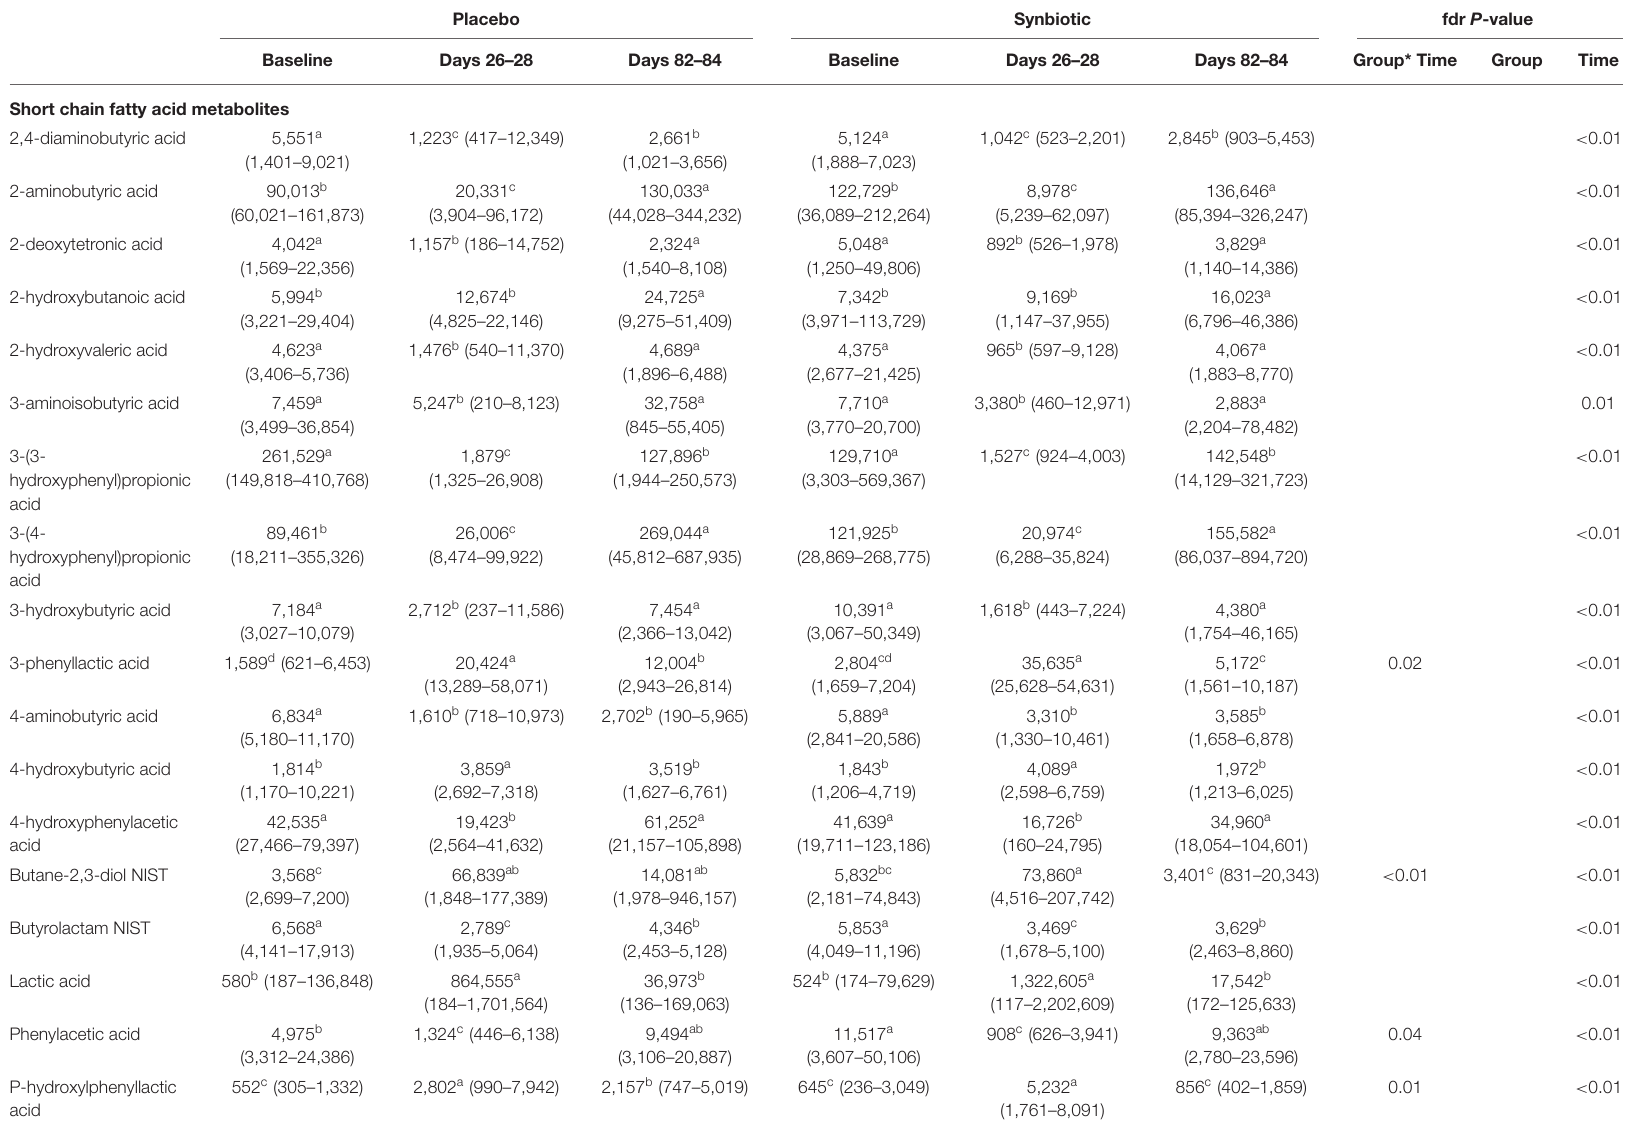
TABLE 4 | Median (range) peak height of metabolites of known biological importance with profiles that significantly differed over the course of the study in feces collected at the conclusion of baseline (days 5–7), antibiotic administration (days 26–28), and a 56-day washout (days 82–84) from 22 healthy dogs, 11 per group, + that received enrofloxacin (10 mg/kg qd) and metronidazole (12.5 mg/kg BID), followed 1h later by placebo or a synbiotic combination (BID) PO for 21